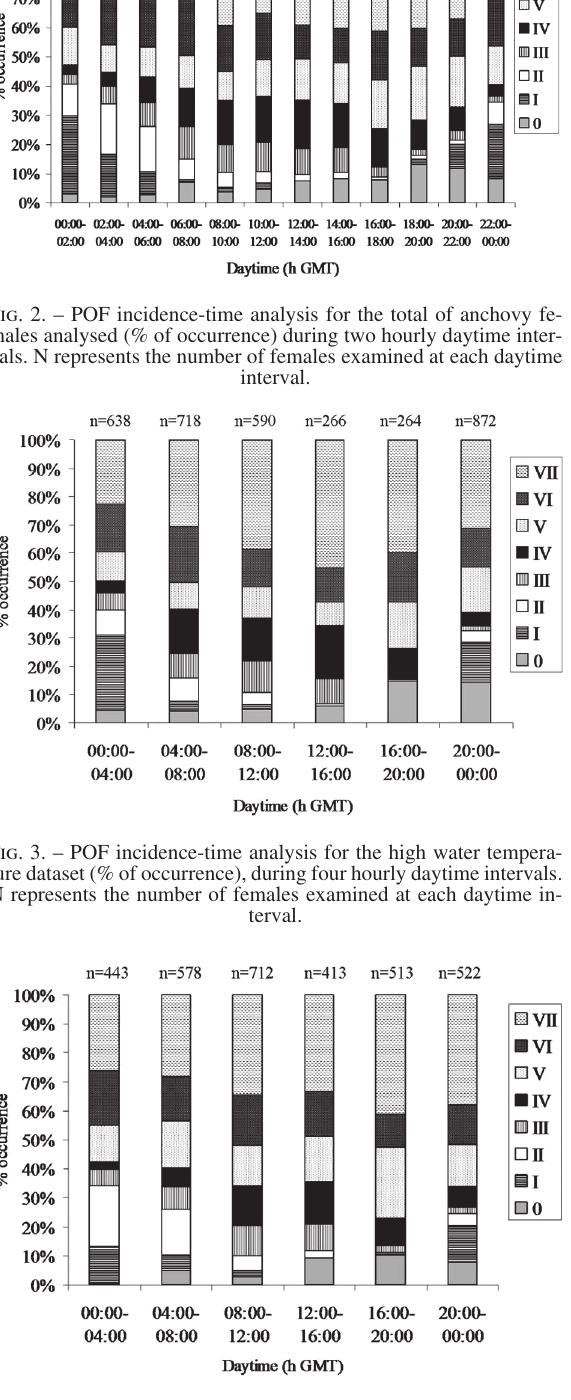
Fig . 4. – PoF incidence-time analysis for the low water tempera- ture dataset (% of occurrence), during four hourly daytime inter- vals. n represents the number of females examined at each day- time interval.